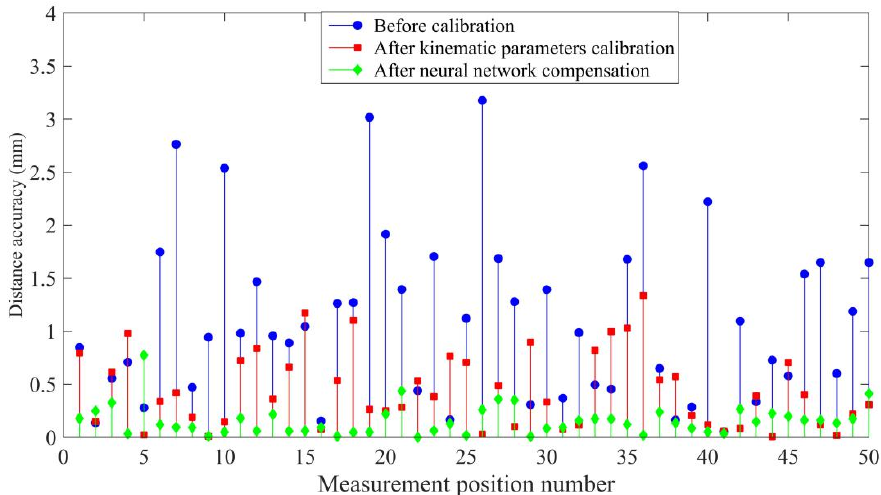
Figure 8. Positioning accuracy of the simulations.